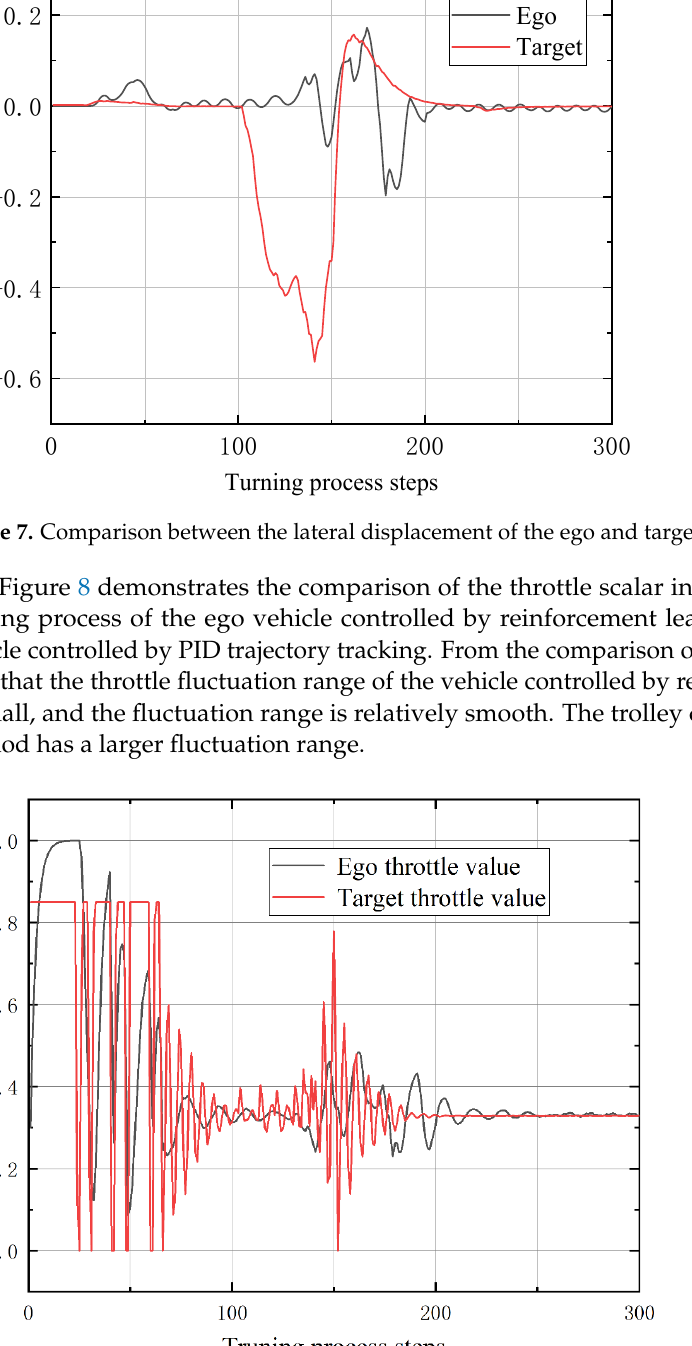
Figure 6. Turning process trajectory comparison chart.